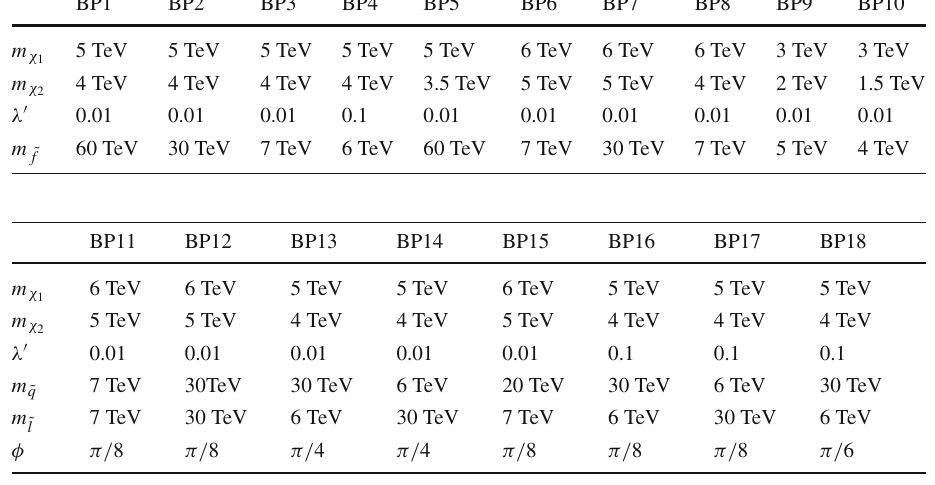
points considered for different plots in Fig. 3a–c. For all these sets φ = π/ 4